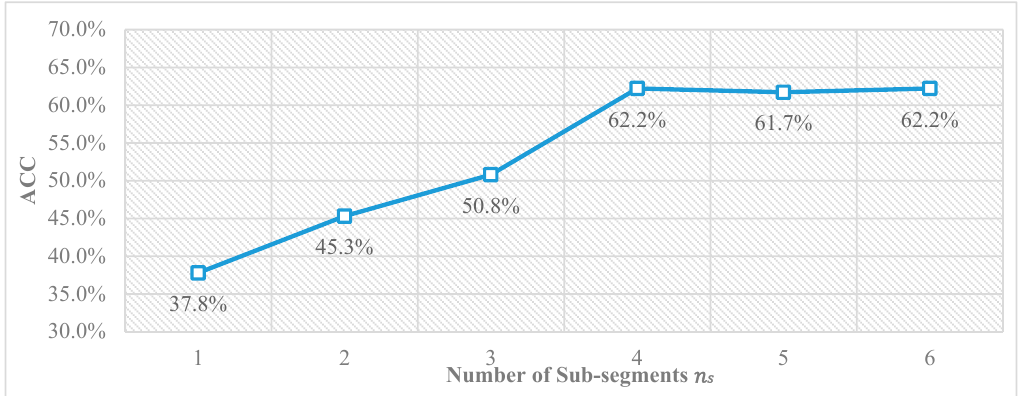
Figure 8. The Impact of Number of Sub-segments (cid:1866) (cid:3046) on ACC (XGBoost).